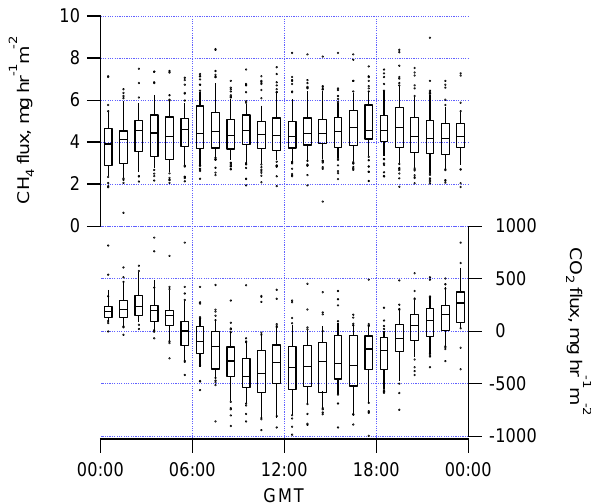
Figure 7. CH 4 and CO 2 hourly fluxes at Sodankylä wetland site between 1 July and 15 August 2012 determined using the eddy co- variance technique. CH 4 diurnal variation is noted to be small. Net CO 2 uptake occurs during the day, with net emission during the night.